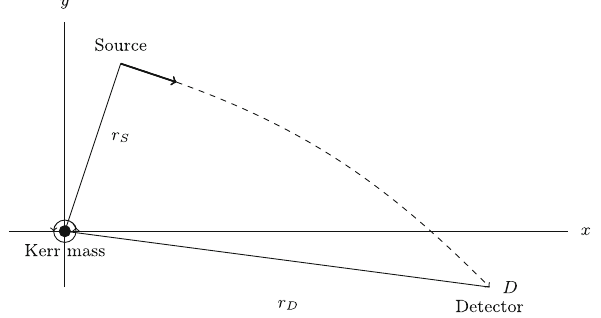
Fig. 1 Diagrammatic representation of the neutrino source and the detector setup, when neutrinos are produced with a non-zero angular momentum L (cid:12)= 0 and propagated away from the gravitational